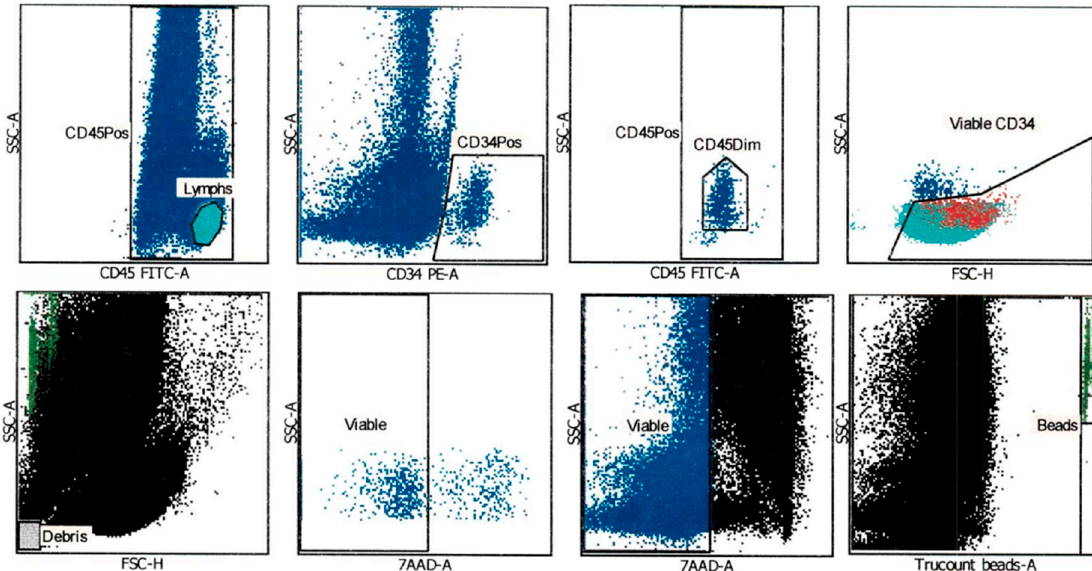
Figure 1. BD FACSCanto clinical software v2.4 standard gating strategy to determine stem cell count and viability with the BD stem cell enumerator kit. The image shows a representative sample of a confirmatory testing assessment by flow cytometry. From left to right in the upper panels, automated gating strategy was performed as follows: lymphocyte population selection (first panel, left), followed by CD34 + cell population (second panel). In the CD34 + cell population, CD45 dim population was selected, which represents the most primitive CD34 + cells (third panel). Location of the CD34 + cells (in red) inside the lymphocyte population (fourth panel) indicated viability. For viability assessment the gating strategy was performed as follows: from left to right in the bottom panels: debris were excluded from the viability and cell count analysis (first panel). Previously selected CD34 + CD45 dim and total CD45 + viability was assessed through negative 7-AAD signal in the second and third panels. In the fourth panel, beads were excluded (by APC + signal) to allow cell count extrapolation.